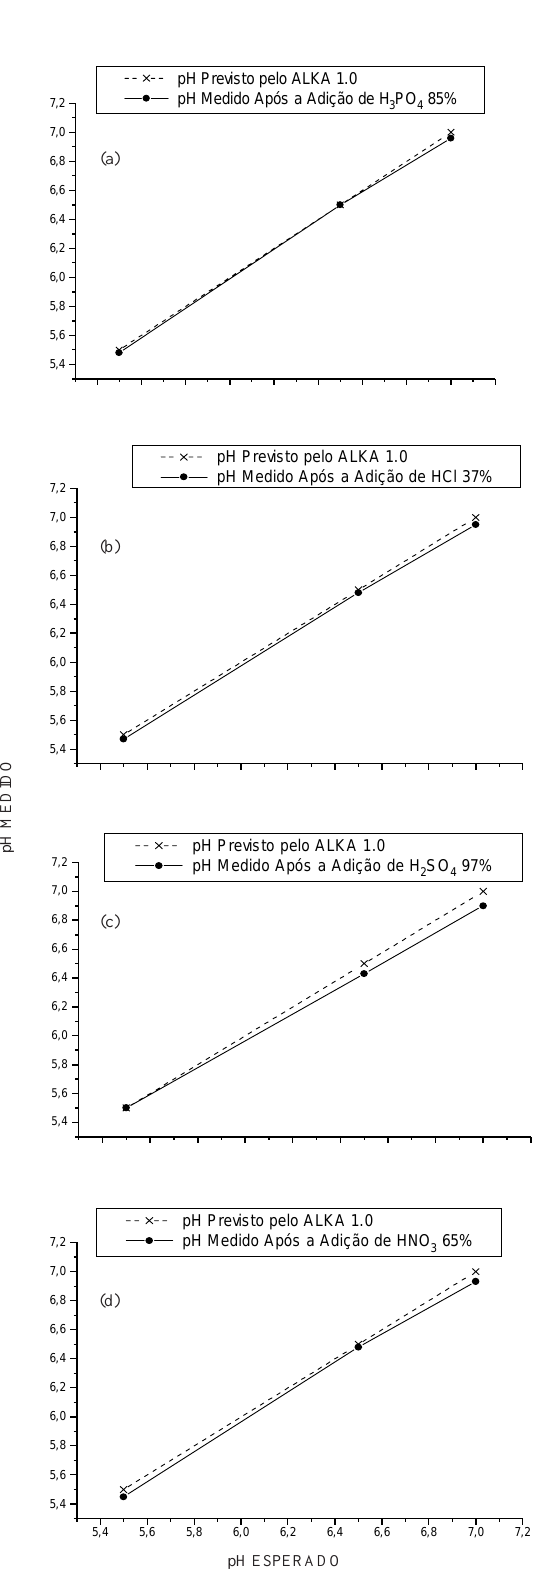
Figura 2. Valores de pH, previstos pelo ALKA 1.0 e medidos após a adição dos volumes calculados (mL L -1 ) de (a) H HNO 3